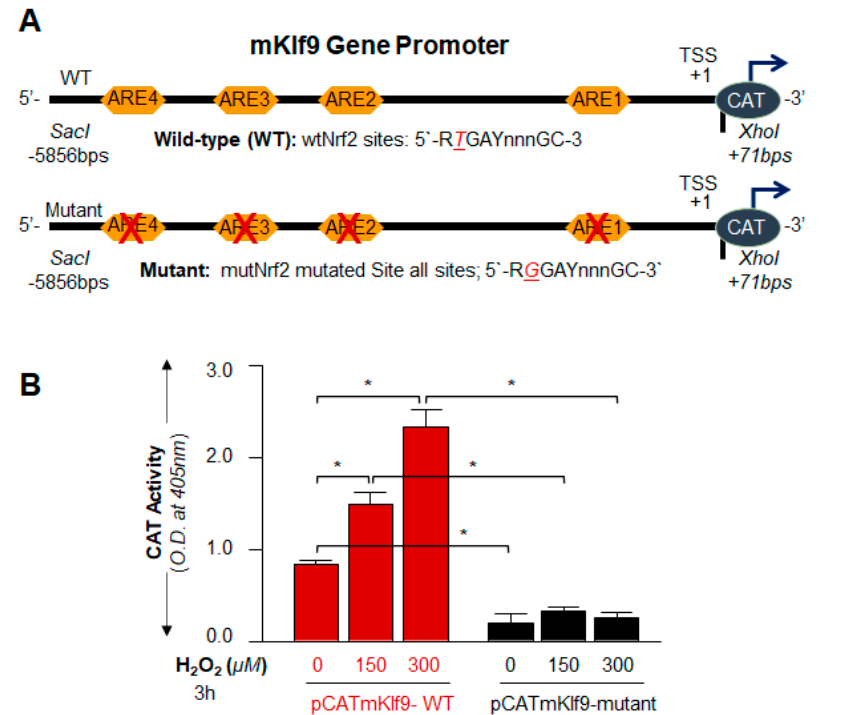
Figure 7. Oxidative load-dependent increase in Klf9’s transcriptional activity through ARE. ( A ) Top panel: diagrammatic illustration of Klf9 promoter containing predicted ARE sites with wild type (WT) ARE and mutant sequence (mutated using SDM). ( B ) hLECs were transfected with WT mouse Klf9 promoter ( − 5856/+71) or its mutant at ARE sites 1 to 4. 48 h later transfectants were treated different concentrations of H 2 O 2 for 3 h as shown, and Klf9 Promoter activity was evaluated. Data are the mean ± S.D. of three independent experiments. Klf9-mutant versus Klf9 WT plasmid linked to CAT vector transfected hLECs and H 2 O 2 treated versus untreated hLECs; * p < 0.001.